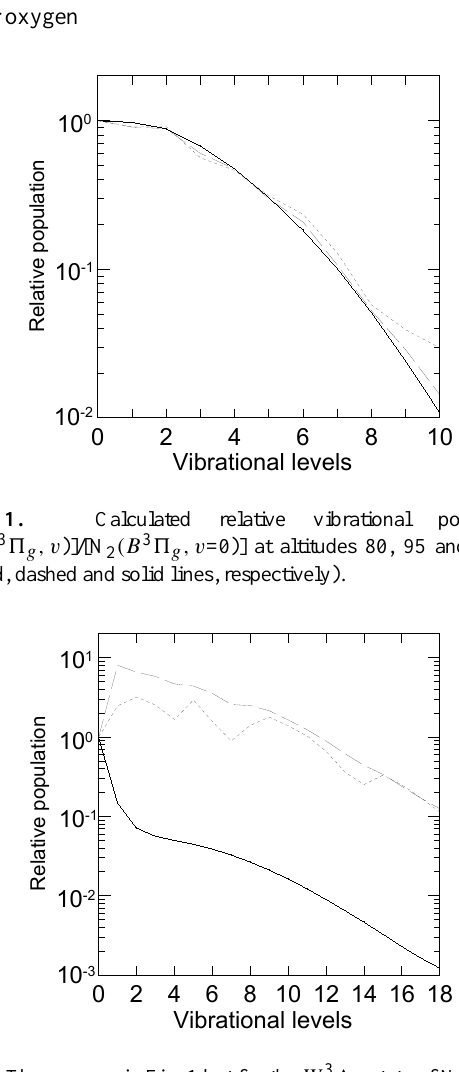
Fig. 2. The same as in Fig. 1 but for the W 3 1 u state of N 2 . Figure 2. The same as in Fig.1 but for the W 3 ∆ u state of N 2 . for intermolecular and intramolecular processes in Eq. (8a) are shown in Table 1. The rate coefficients k ∗ YZ and k † YZ v v mean sums of k ∗ YZ and k † YZ on quantum number v 0 . Sim- vv 0 vv 0 0 3 6 − ilar rate coefficients for B 3 5 g , W 3 1 u , B states of N 2 u applied in Eqs. (8b–d) are shown in Tables 2–4, respectively. Results of our calculation of relative vibrational popu- lations ([N 2 ( B 3 5 g , v )]/[N 2 ( B 3 5 g , v =0)], [N 2 ( W 3 1 u , v )]/ 0 3 6 − , v )]/[N 2 ( B 0 3 6 − , v =0)]) at al- [N 2 ( W 3 1 u , v =0)], [N 2 ( B u u titudes of 80, 95 and 150 km of auroral upper atmosphere are shown in Figs. 1–3, respectively. It is seen from Figs. 2 and 3 that there is the influence of collisional processes on 0 3 6 − the distributions of W 3 1 u and B states. For the W 3 1 u u state the increase in the density of the atmosphere causes the rise of the population for the vibrational levels v ≥ 1. For the B 0 3 6 − state the similar increase causes the rise in the pop- u ulation of the lowest v =0–2 vibrational levels in comparison with the maximum in the